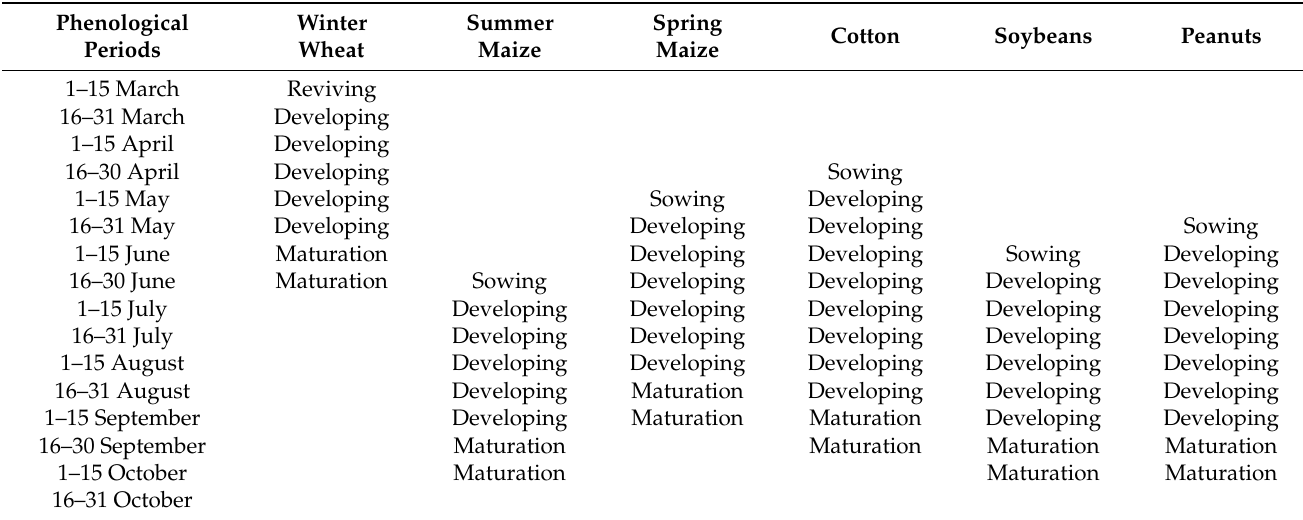
Table 4. Phenological information of main crops in Hengshui